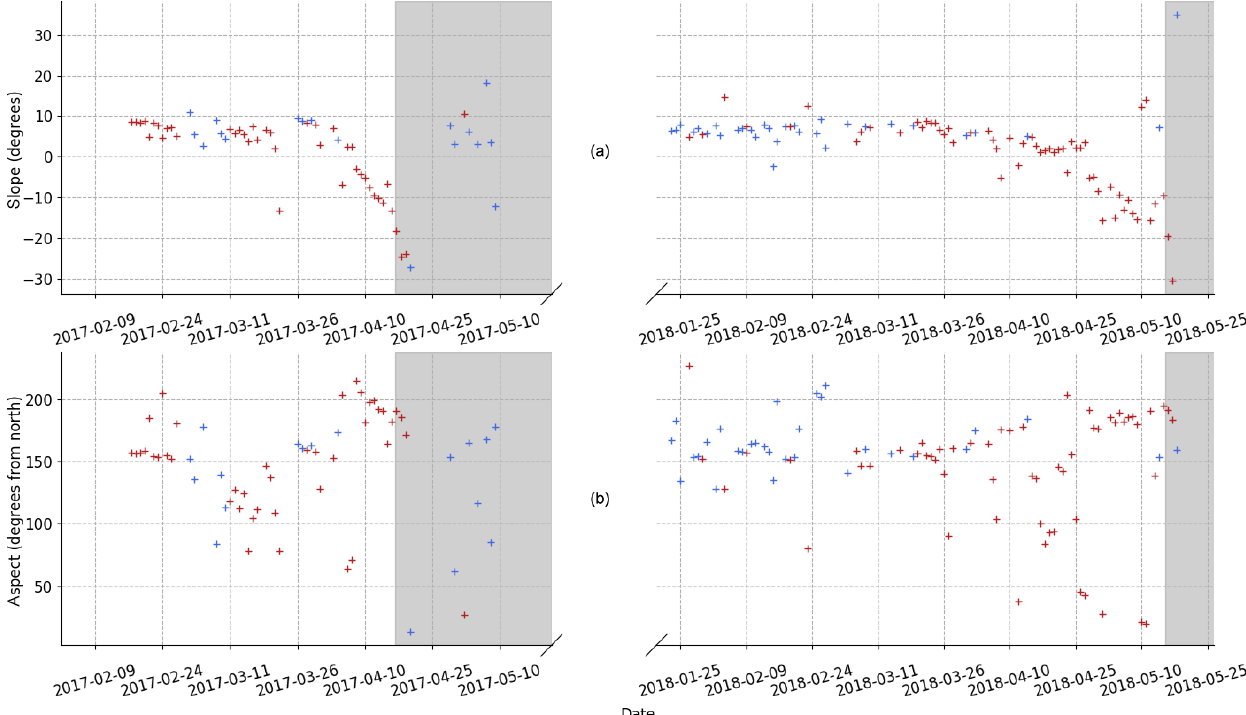
Figure C2. Estimations of the slope (a) and aspect (b) of the snow surface from the Autosolexs sensor. The estimation is more robust for low solar elevations and low near-surface AEC. Grey shading corresponds to areas with less than 20cm of measured snow